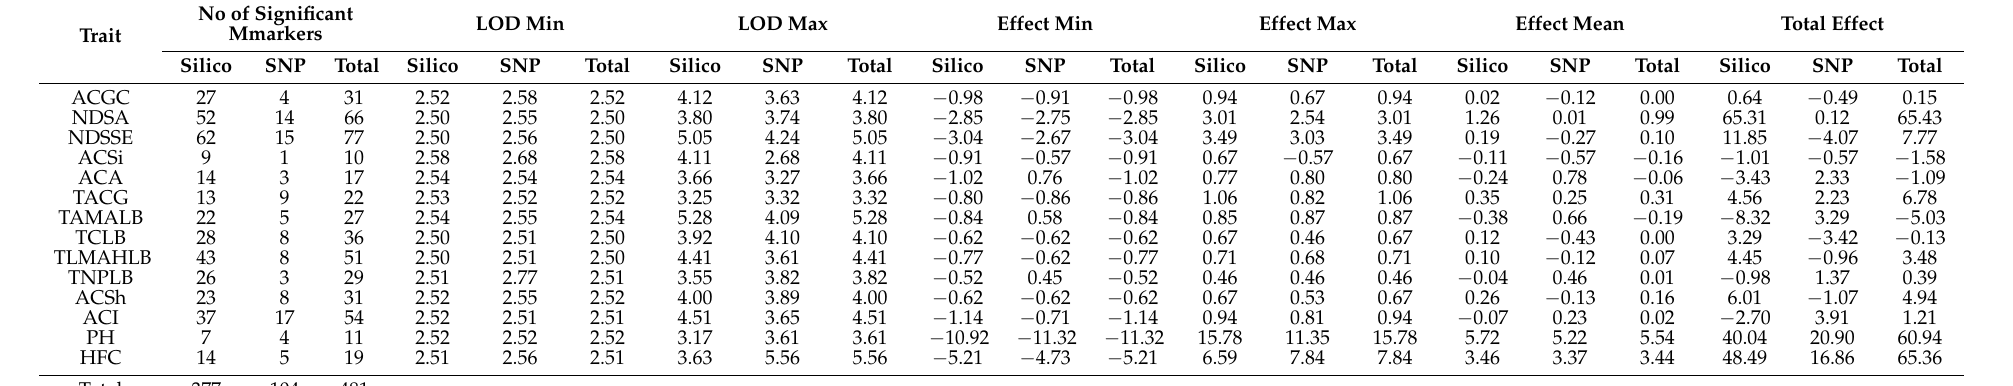
Table 1. Associations between markers (Silico and SNP) and studied traits found in the genome-wide association mapping with allelic substitution effects (significant associations selected at p < 0.05 with correction for multiple testing by the Benjamini–Hochberg method).